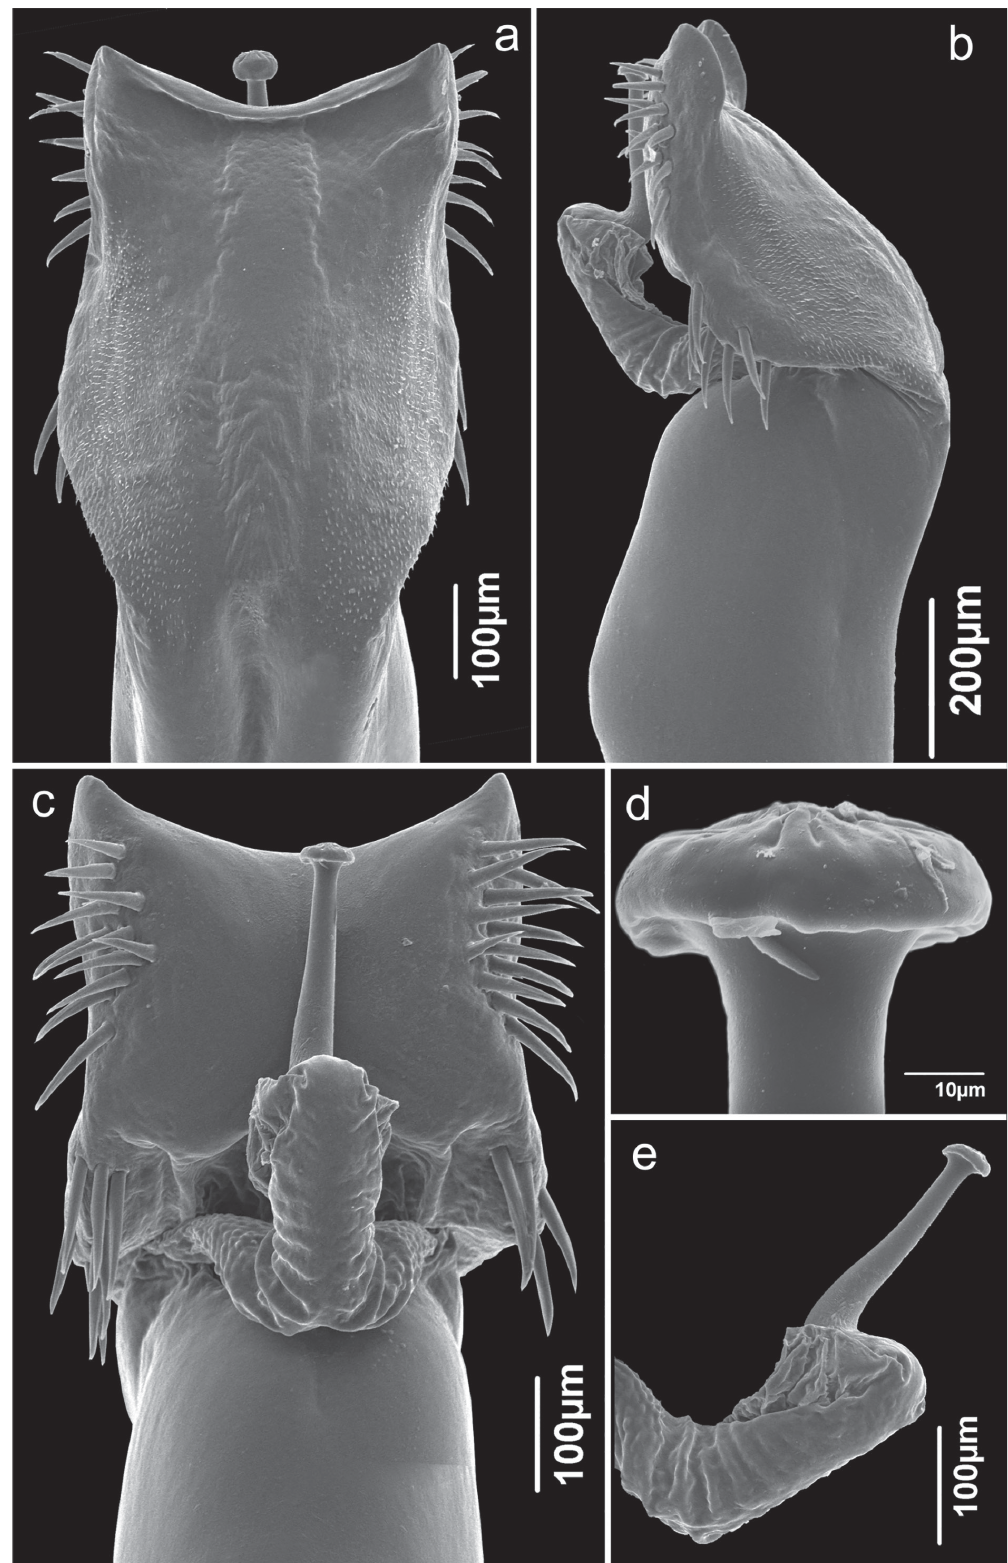
Fig. 6. Phalangodus briareos sp. nov., holotype, ♂ (MNRJ 2382), penis distal portion. a . Ventral view. b . Lateral view. c . Dorsal view. d . Stylar caps, dorsal view. e . Stylus, lateral